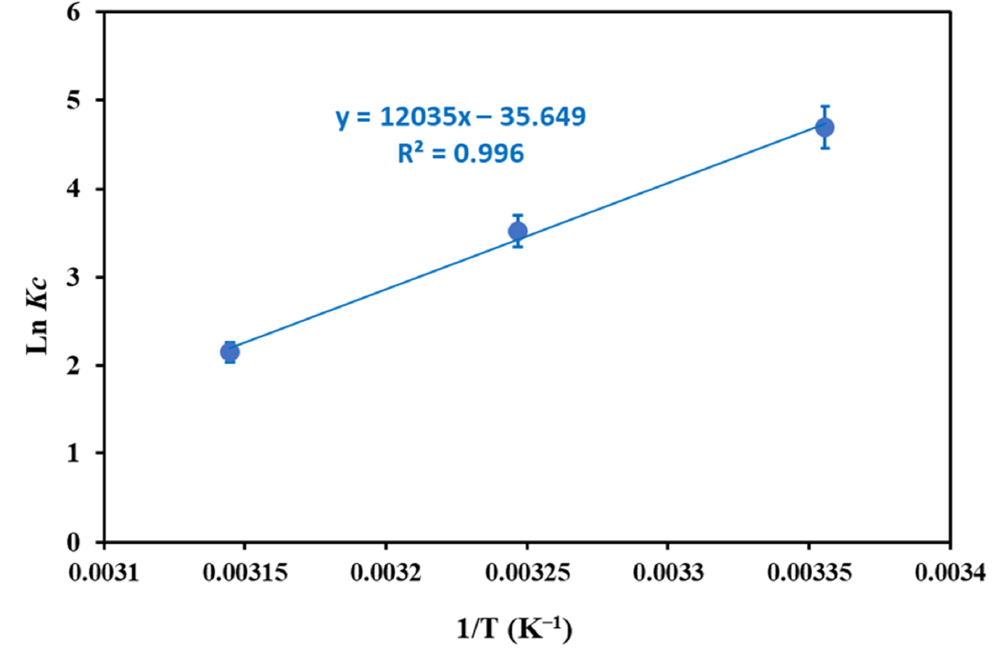
Figure 9. Plot of ln K vs. 1/T for thermodynamic parameters calculation. Table 4. Thermodynamic parameters for the adsorption of CV on CS-HAP-CeO 2 heterostructure adsorbent.